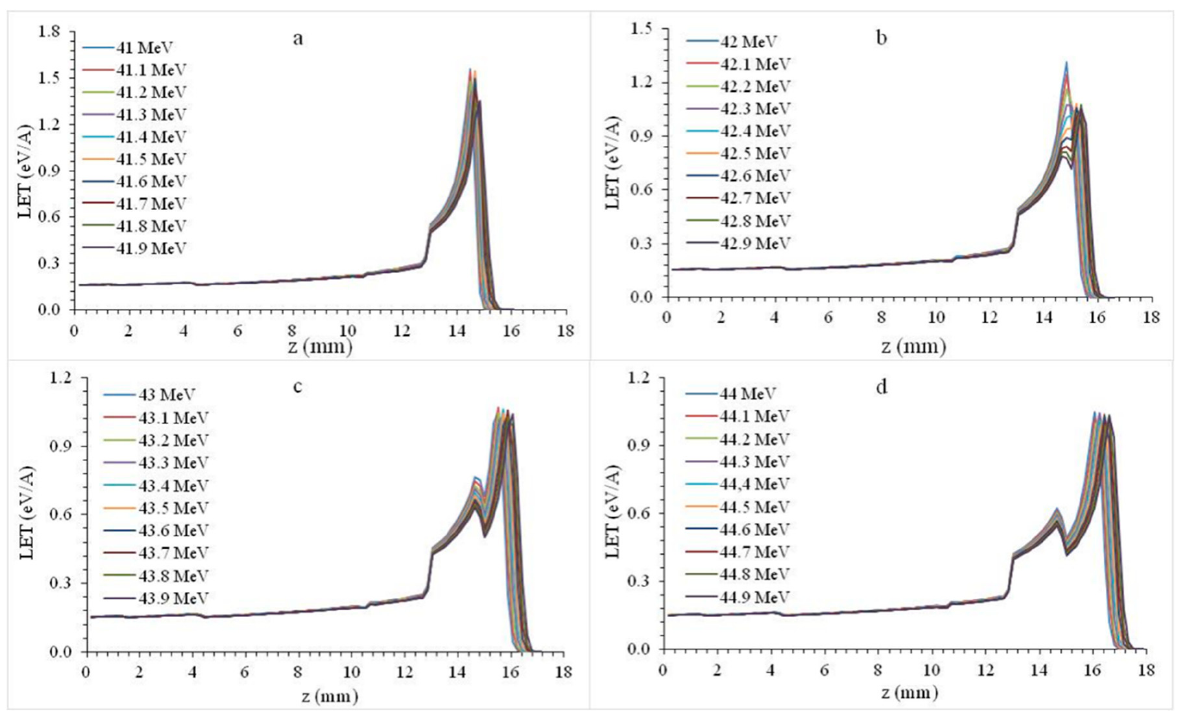
Figure 2. Bragg curves formed by 41–44.9 MeV ( a – d ) energy protons in premolar plate phantom.